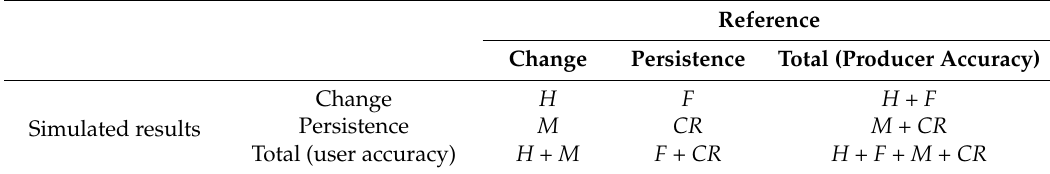
Table 3. Contingency Table.